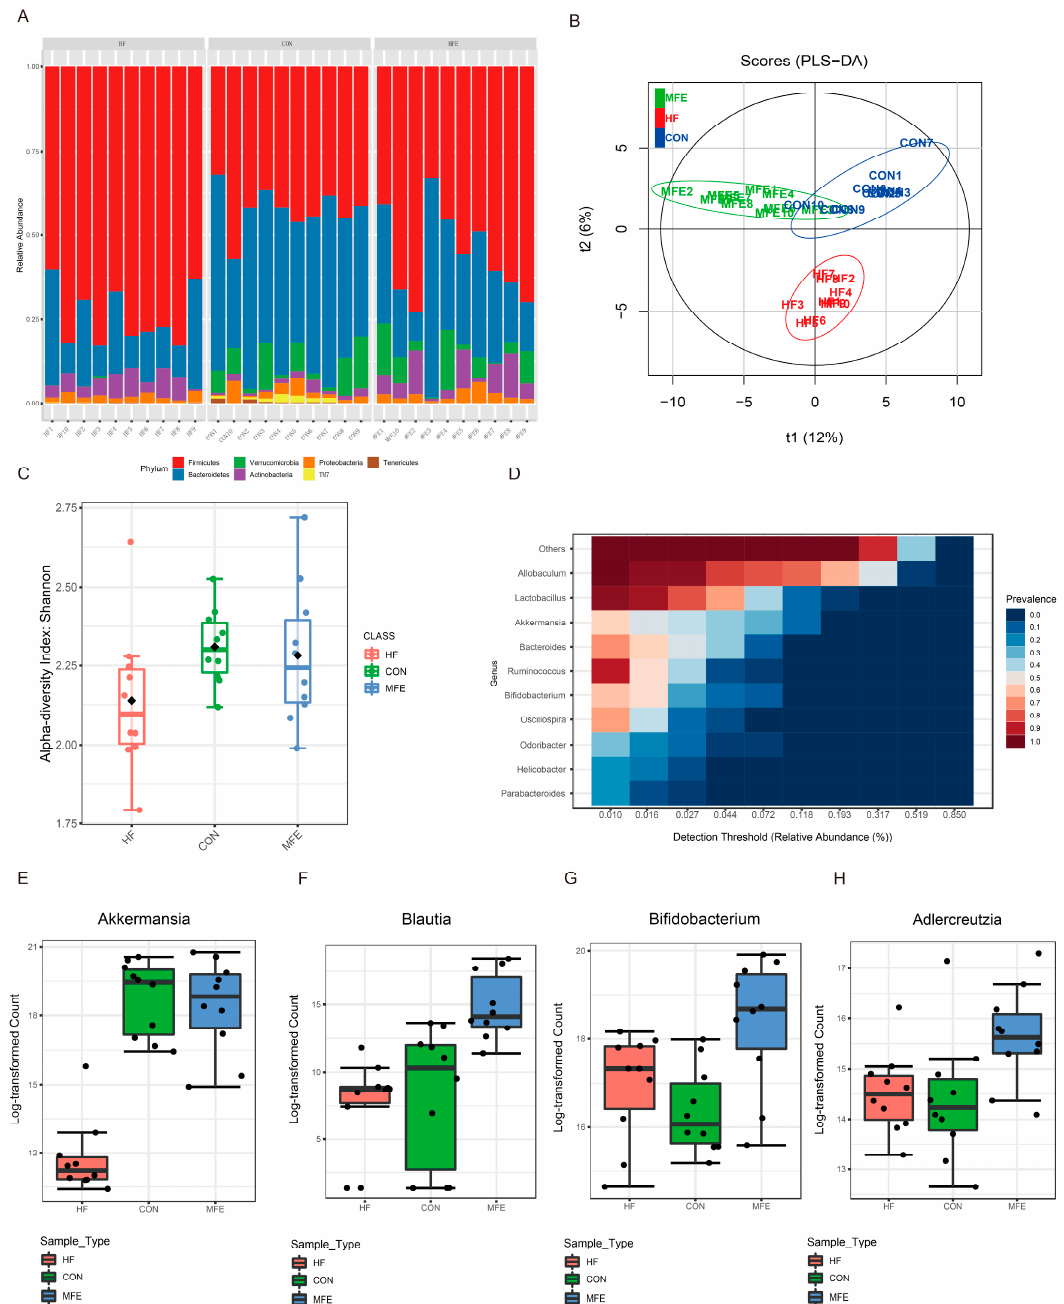
Figure 2. Effects of MFE on the abundance and diversity of gut microbiota. ( A ) Bacteria composition at the phylum level in each sample (top7). ( B ) Partial least-squares discriminant analysis (PLS-DA) of beta diversity in three groups (CON, HF, and MFE). ( C ) The Shannon diversity index of alpha diversity in three groups (CON, HF, and MFE). ( D ) Correlation analysis of the core gut bacteria at the genus level. ( E – H ) The bacteria (( E ) Akkermansia, ( F ) Blautia, ( G ) Bifidobacterium, and ( H ) Adlercreutzia) were significantly upregulated by MFE at the genus level in high-fat-diet mice. Data are shown as mean ±